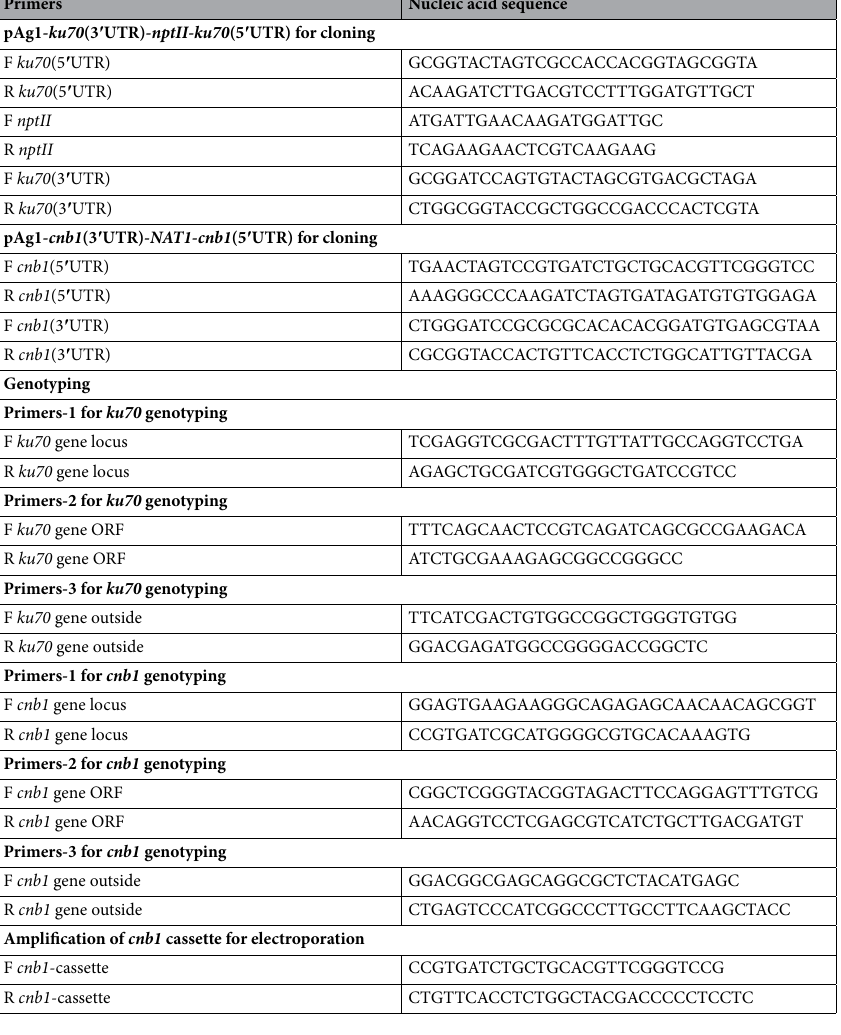
Table 2. Primers used in this